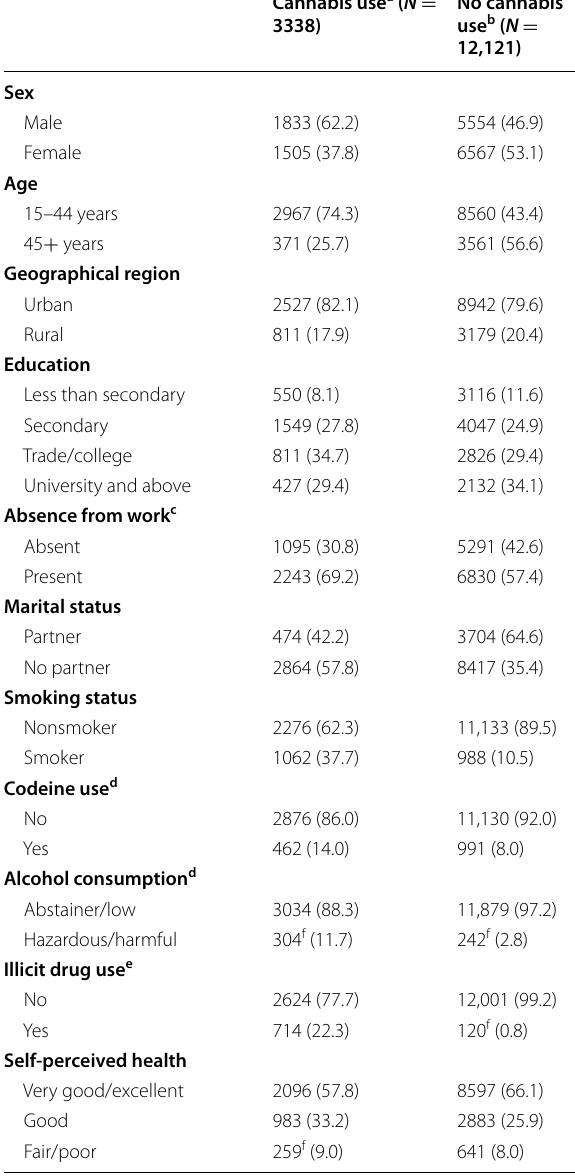
Table 1 Characteristics of the study sample according to self- reported cannabis use, Canadian Tobacco, Alcohol and